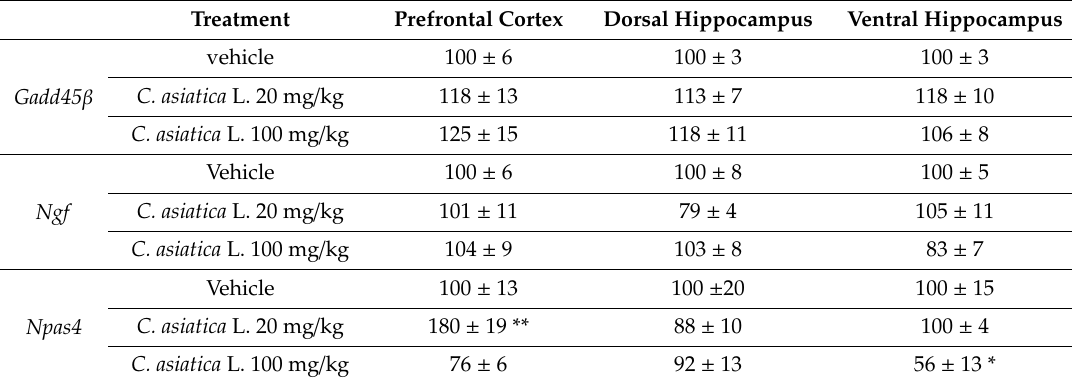
Table 5. Gadd45 β , Ngf and Npas4 mRNA